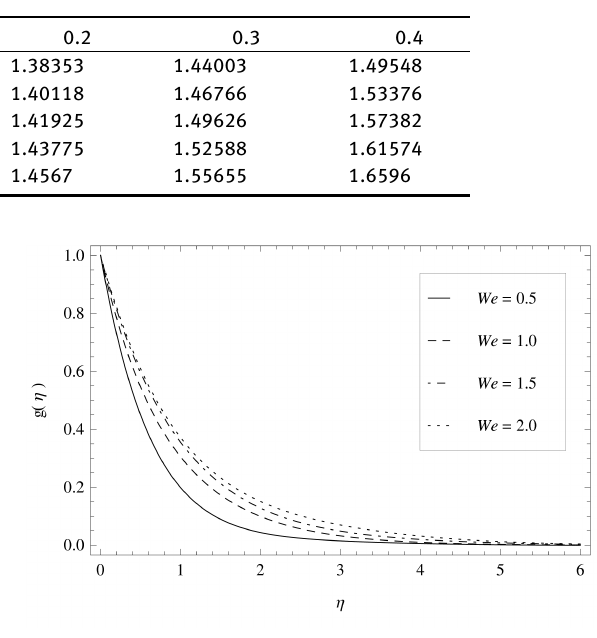
Fig. 7: The influence of a parameter α on g ( η ) for We = 0.9, λ = 2, M = 3, f = 0.2 and (cid:126) = −0.1 w